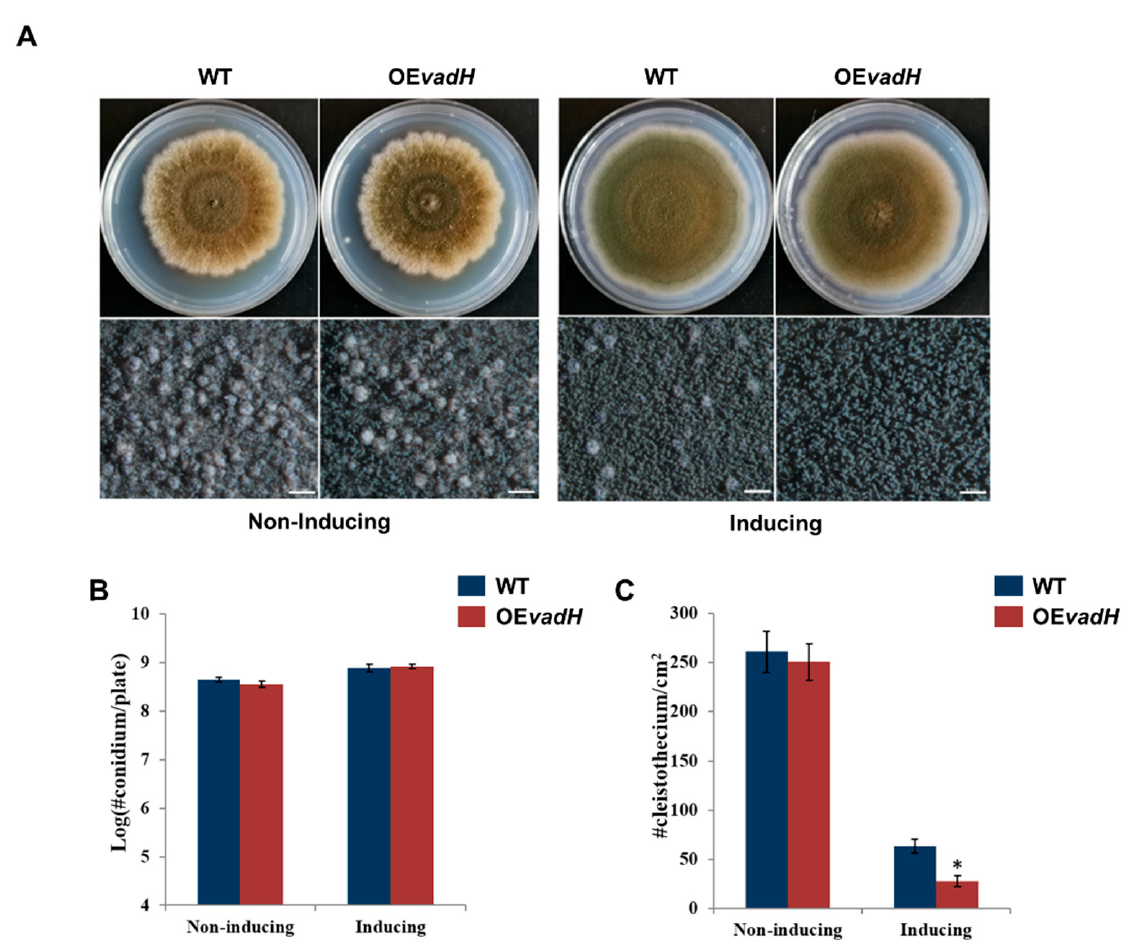
Figure 6. Effects of overexpression of vadH on the development of A. nidulans . ( A ) WT and OE vadH were inoculated onto solid MMG (non-inducing) and MMT (100 mM threonine, inducing) and cultured at 37 ◦ C for 7 days. The bottom panel shows close-up views of the colony in the top panel (Bar = 0.5 mm). ( B ) Statistical analyses of conidial yields under non-induced and induced conditions. ( C ) Statistical analyses of cleistothecia under non-induced and induced conditions. The asterisk represents significant level (* p < 0.05).